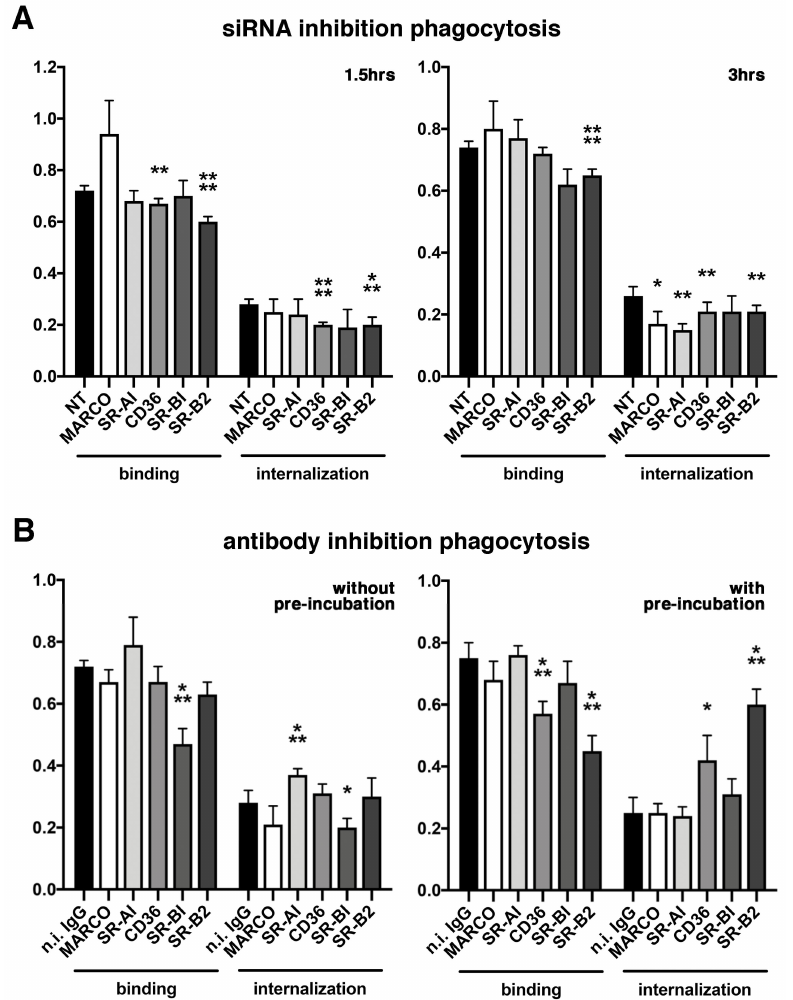
Figure 4. Various effects of receptors inhibition on POS phagocytosis. siRNA inhibition ( A ) assays show that class A MARCO and SR-AI downregulation only decreased POS internalization at 3 hours (right) but neither POS binding nor any phagocytosis step at 1.5 hours (left), as indicated. Class B CD36 and SR-B2 / LIMP-2 downregulation decreased both POS binding and internalization at 1.5 hours, CD36 internalization at 3 hours and SR-B2 / LIMP-2 binding and internalization at 3 hours. Downregulation of SR-BI had no effect on POS phagocytosis. NT: Non-targeting control. Antibody inhibition assays ( B ) show that blocking SR-AI increased POS internalization while blocking SR-BI decreased POS binding and internalization when antibodies were applied without pre-incubation (left bar graph). Pre-incubation (right bar graph) shows decreased POS binding and increased